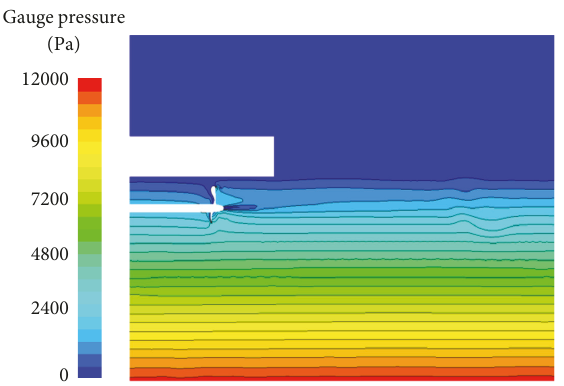
Figure 20: Gauge pressure contour of the entire